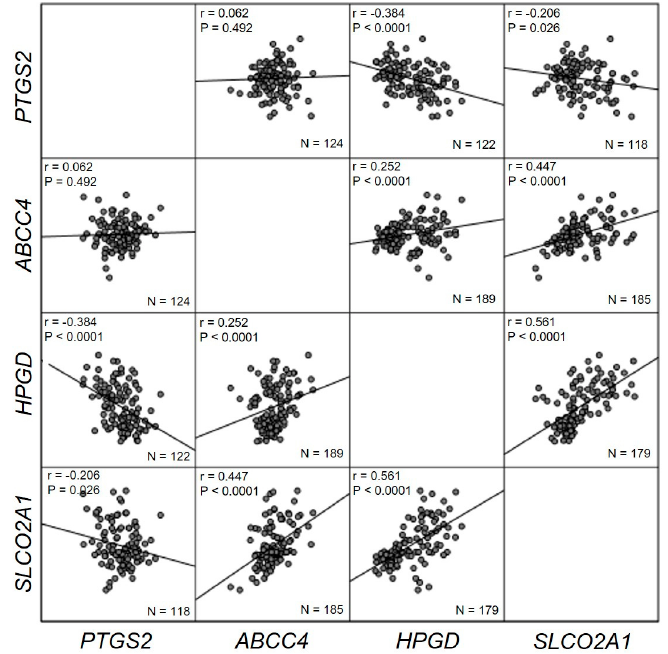
Figure 4. Pearson’s correlation coefficient test. PTGS2 mRNA expression is negatively correlated with HPGD and SLCO2A1 . On the other hand, there is a positive correlation between the expression of ABCC4 , HPGD , and SLCO2A1 . No significant correlation was found between PTGS2 expression and ABCC4. Values were considered statistically significant at p < 0.05.